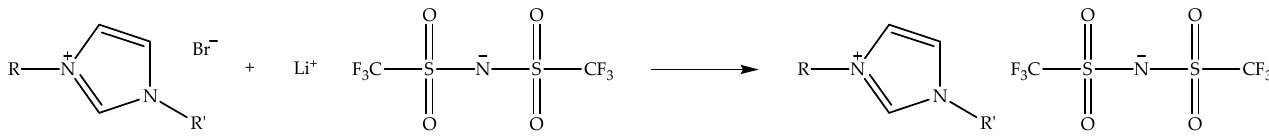
Figure 5. Schematic of the metathesis reaction of alkylimidazolium bromide with lithium bis(trifluoromethylsulfonyl)imide to prepare alkylimidazolium bistriflimide ionic liquid.